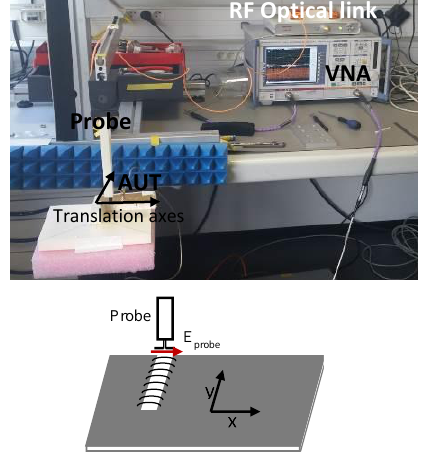
Figure. 10. Demonstrator setup